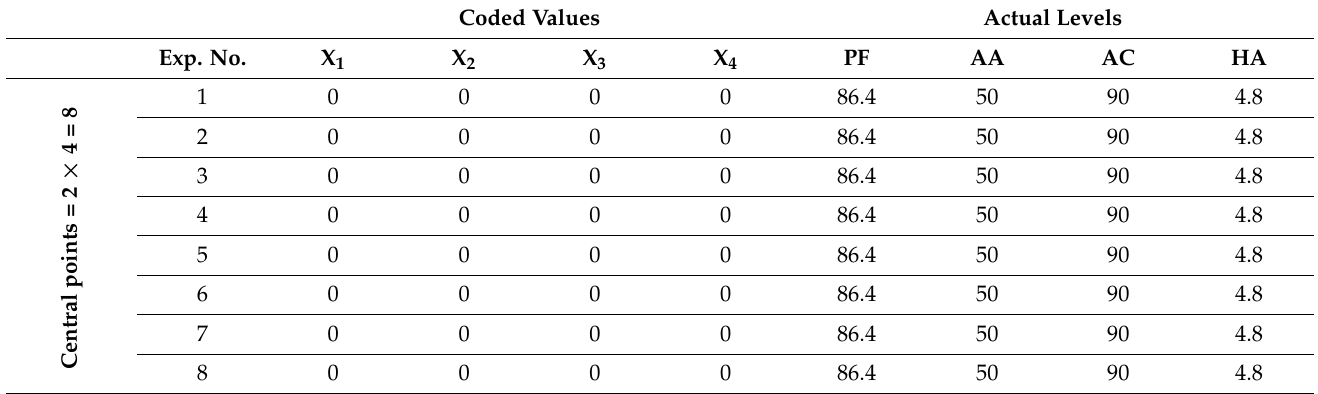
Table 3. Points of central composite design of experiments in coded values and actual